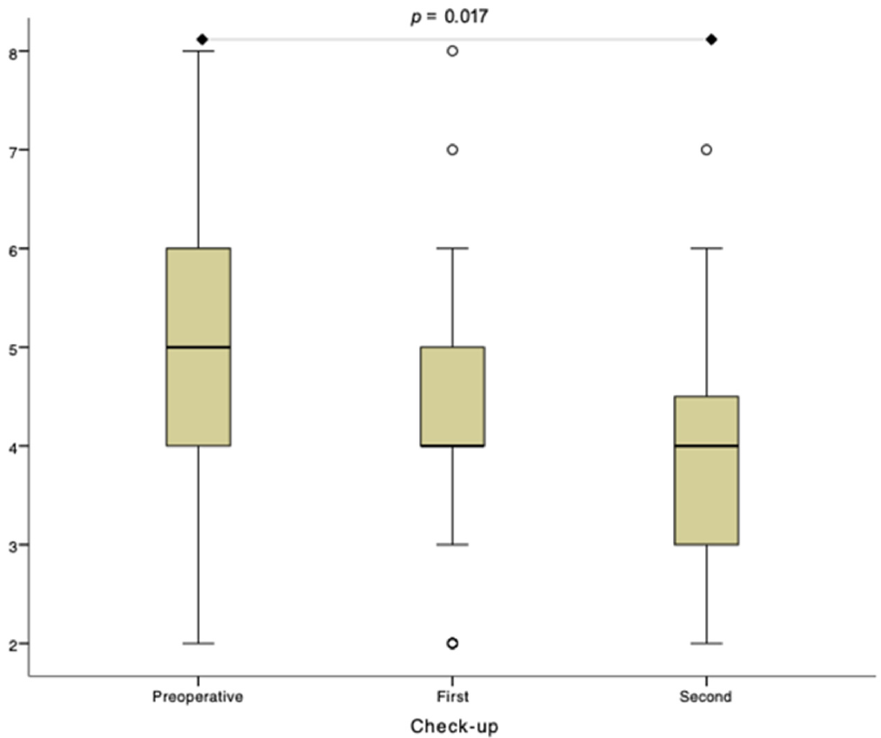
Figure 3. The number of fungiform papillae (N papillae ) analysis within the test side. First check-up was performed 1 month and second check-up 6 months postoperatively.